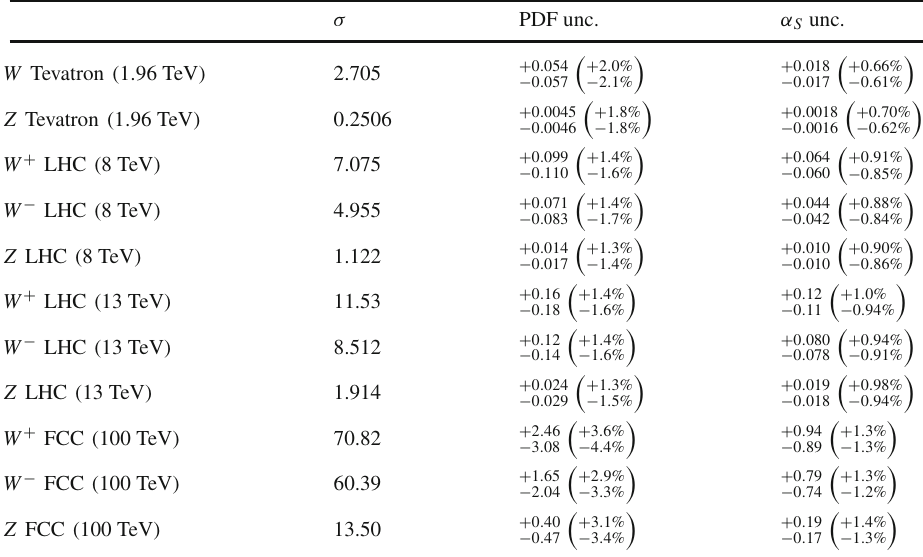
Table 2 Predictions for W ± and Z cross sections (in nb), including leptonic branching, obtained with the NNLO MSHT20 parton sets. The PDF and α S uncertainties are shown, where the α S uncertainty corresponds to a variation of ± 0 . 001 around its central